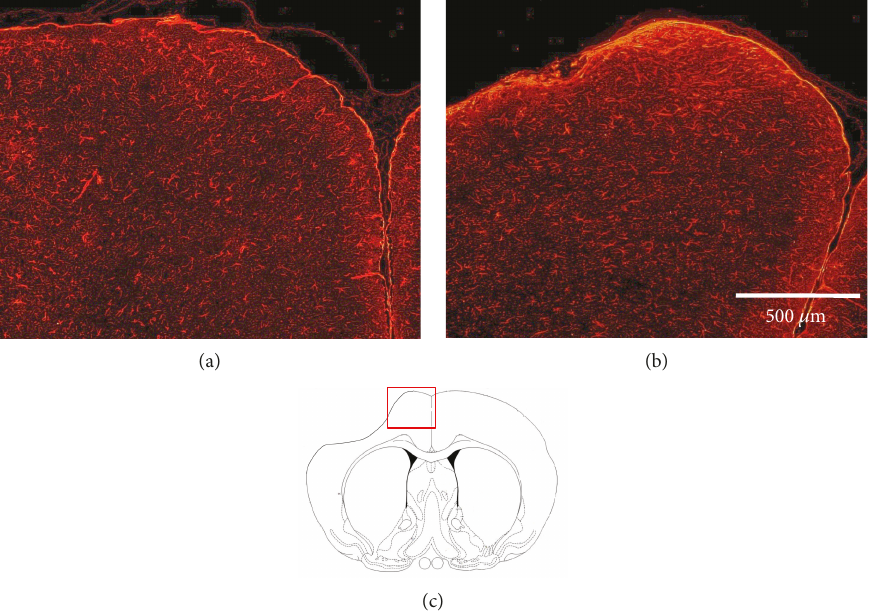
Figure 4: Immunohistochemistry for GFAP. Panels (a) and (b) show the fl uorescence photomicrographs of GFAP 5 weeks posttransplantation in the BMSC/direct injection (a) and BMSC/sca ff old (b) groups. A red rectangle in panel (c) indicates the location. Scale bars: 500 μ m.